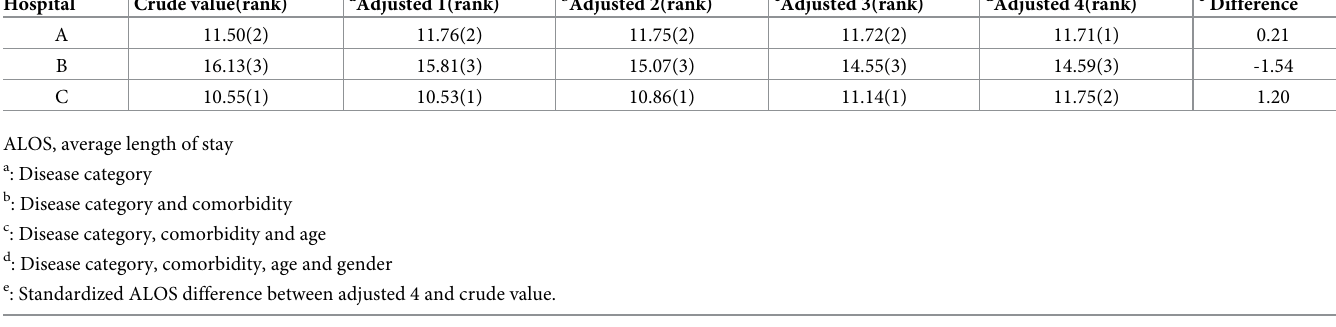
Table 7. Results of standardized ALOS among three hospitals based on confounding factor stratification. Hospital